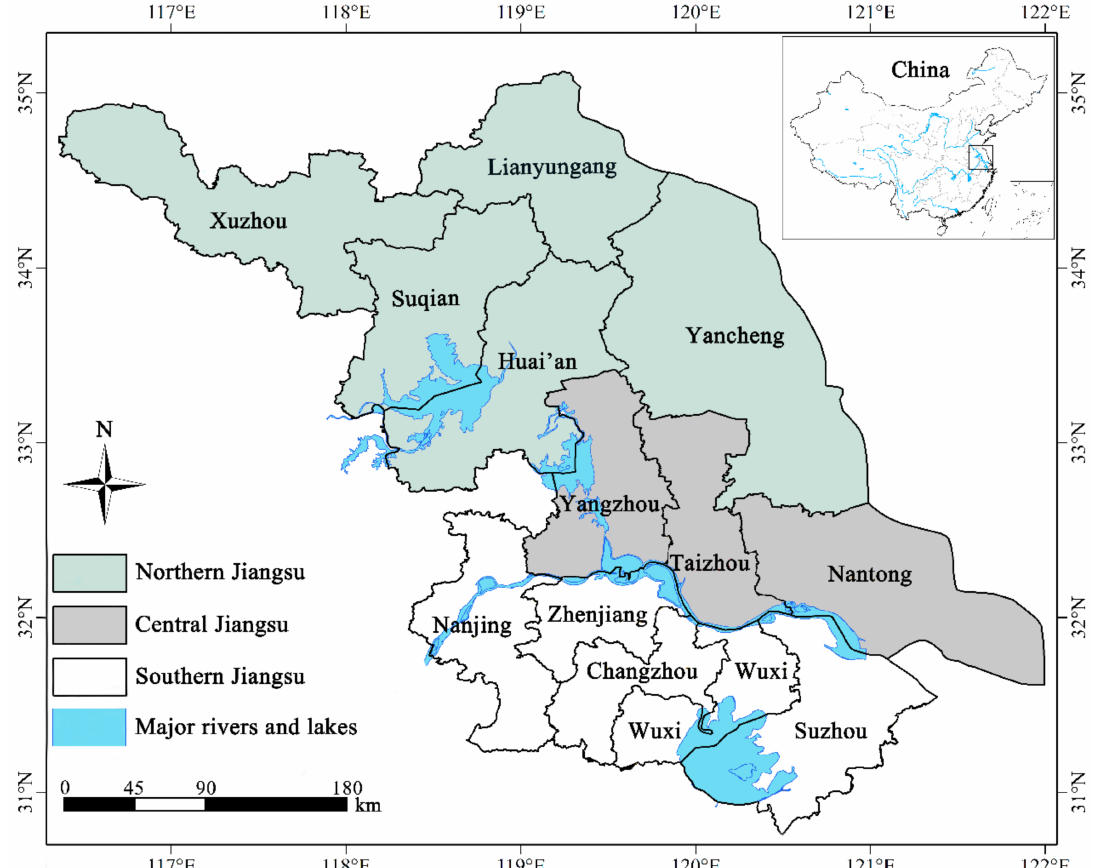
Figure 1. Sketch map of study area of heritage trees in Jiangsu Province, eastern